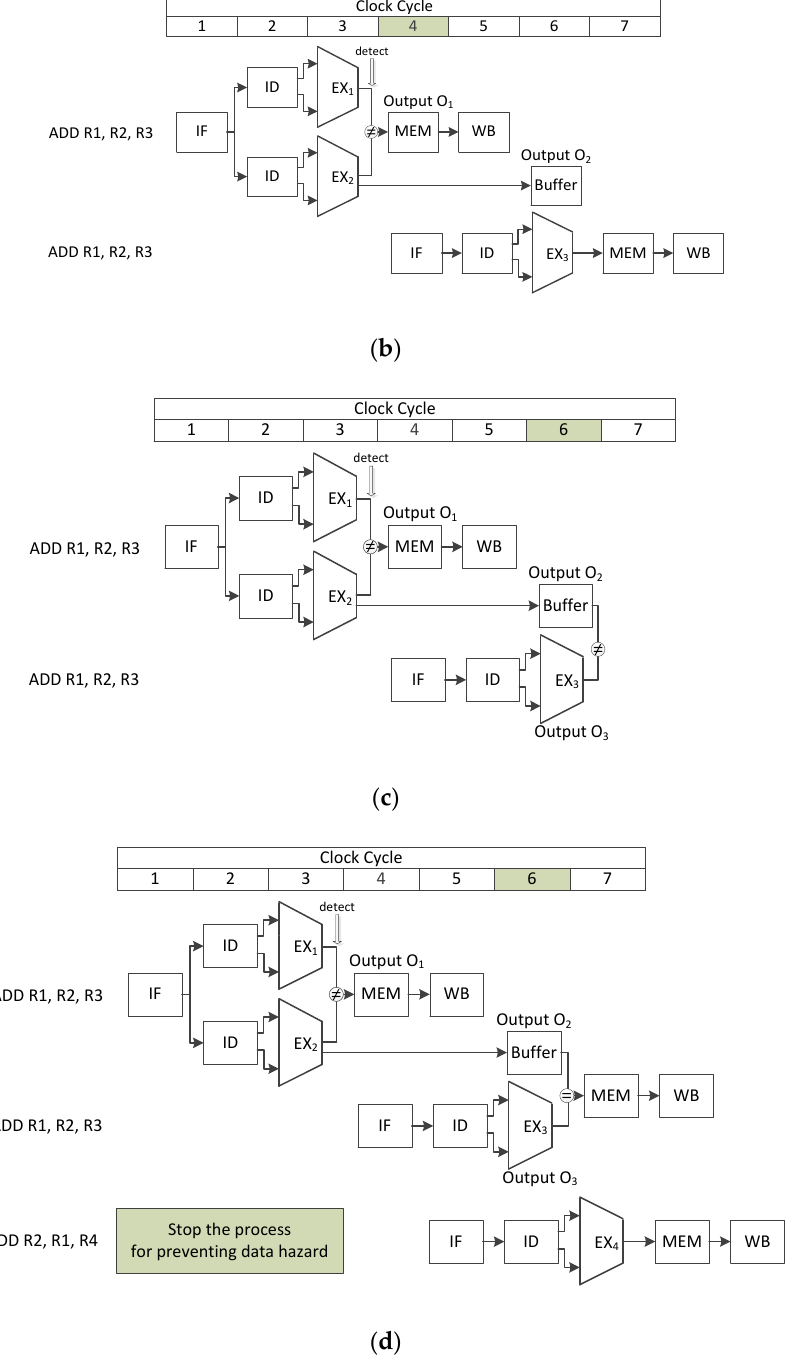
Figure 3. Example of a PRECOR execution. ( a ) The error detection step of PRECOR in pipeline stage. ( b ) The roll-back step of PRECOR in pipeline stage. ( c ) The recovery step of PRECOR in pipeline stage, prediction success case. ( d ) The recovery step of PRECOR in pipeline stage, prediction failure case.